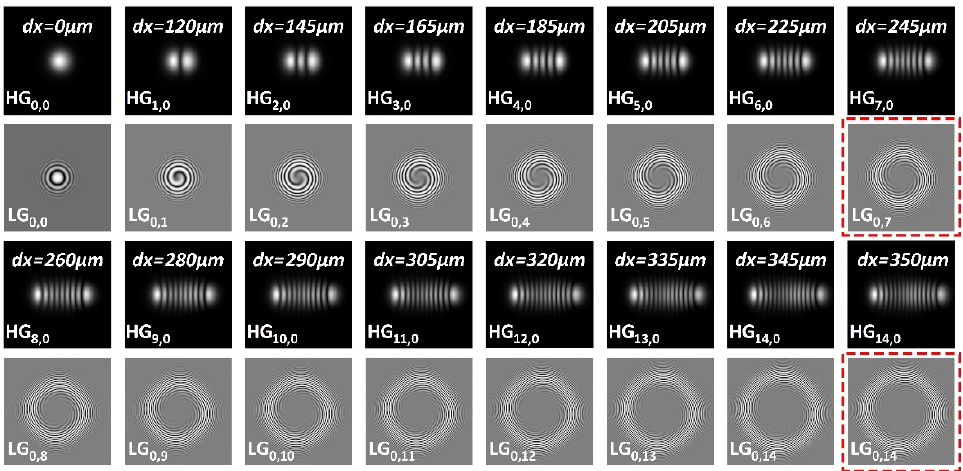
Figure 8. Generation of HG and vortex beams with single off-axis displacement.